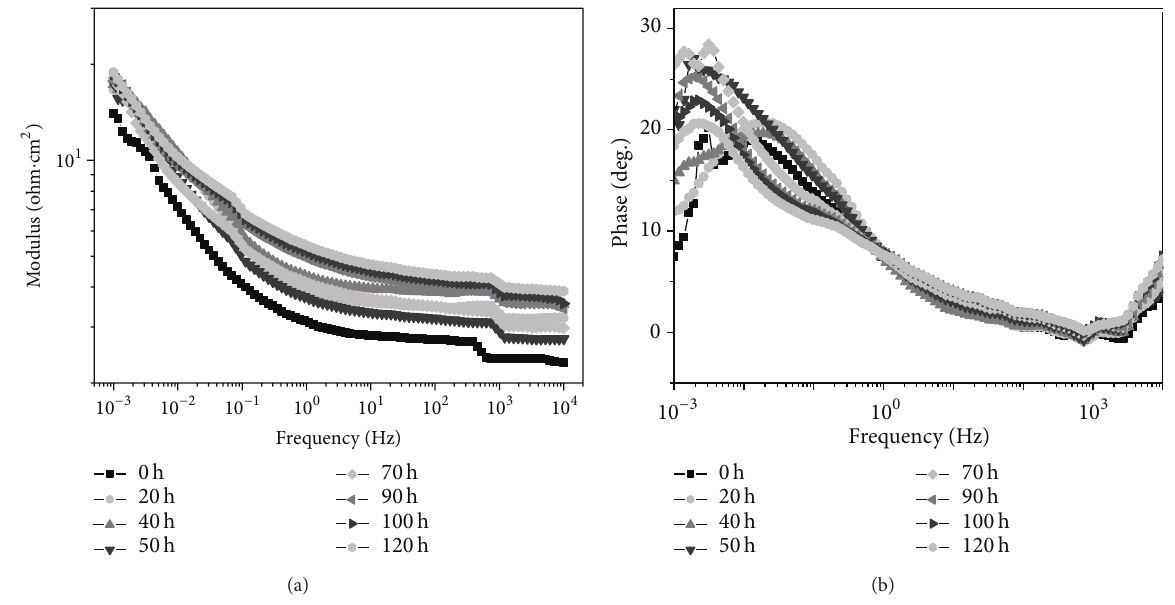
Figure 7: Bode plots for stainless steel 309 exposed to molten salts 50mol% V 2 O 5 -50mol% Na 2 SO 4 at 700 ∘ C.